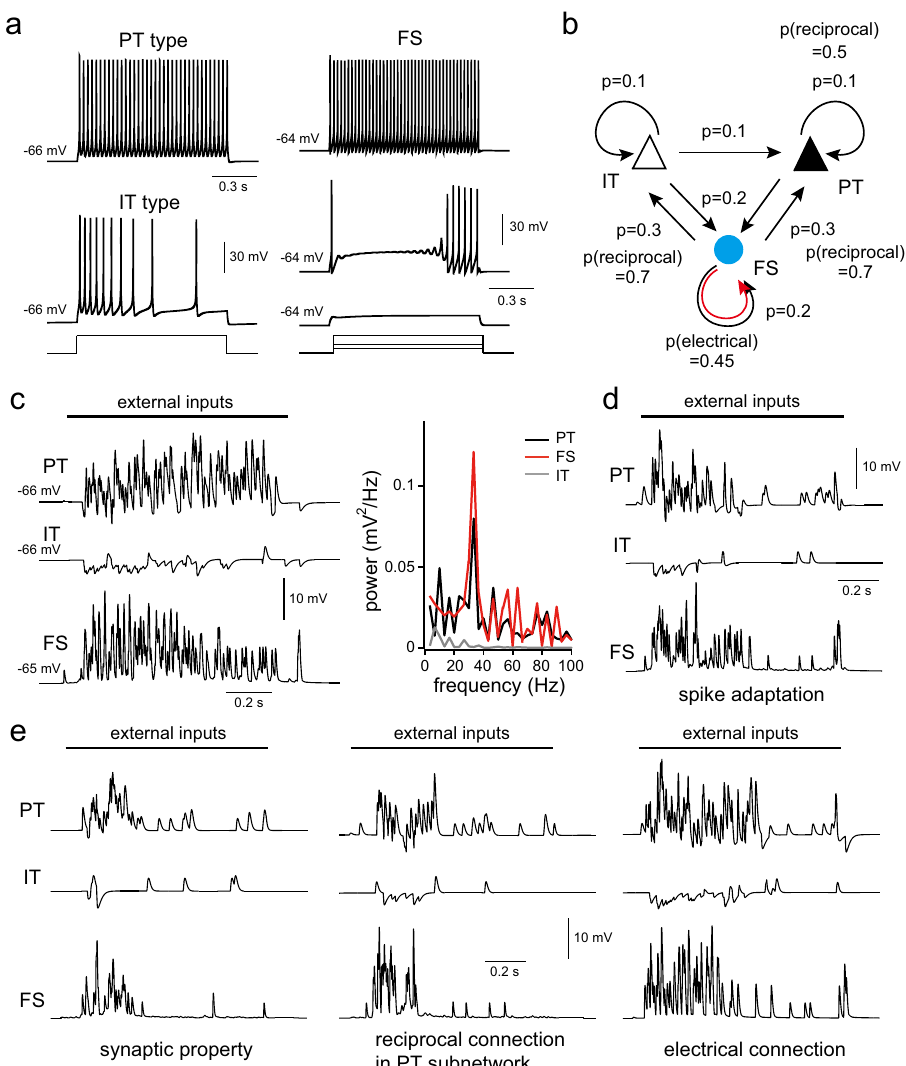
Fig. 5 Induction of oscillations in L5 model circuits. a Firing properties of PT, IT, and FS cell models in response to somatic current injection. b Connectional features of L5 cells in the model circuits. Black and red arrow indicates chemical and electrical synaptic connection, respectively. ‘ p ’ indicates synaptic connection probability to surrounding cells located within a 150 μ m distance. ‘ p(reciprocal) ’ indicates reciprocal connection probability among connected cells. c Somatic membrane potentials of PT, IT, and FS cells in the network model. External inputs were applied to all cell models. Right graph indicates power spectra of membrane potentials in the presence of external inputs. c , e Somatic membrane potentials of PT, IT, FS cells in the model with modi fi cation of model parameters. d Firing properties in PT cell models were changed from slow to fast spike adaptation type by increasing the M type potassium conductance to 1. e Manipulation of connection properties in PT and FS cell subnetworks in the model. Left, short-term plasticity of PT cells was changed from facilitation to depression type, similar to that of IT cells. Middle, reduction of the reciprocal connection probability in the PT cell subnetwork from 0.5 to 0.1. Right, removal of electrical connections among FS cells. Sodium conductance was set to 0 in cells shown in ( c – e